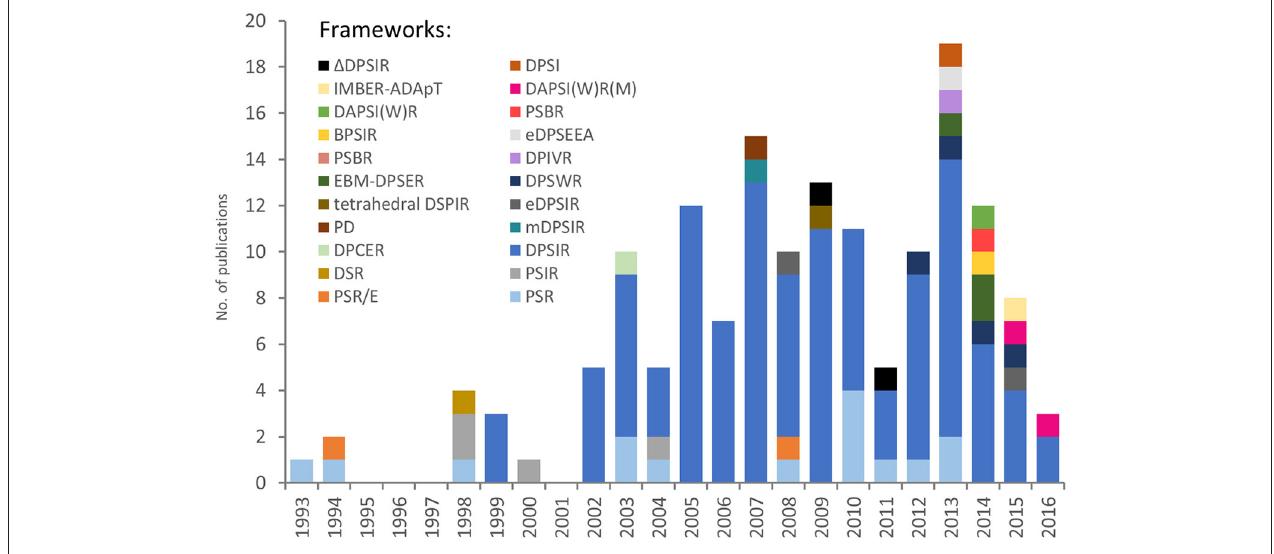
FIGURE 3 | Studies published per year (from those included in the review, N =